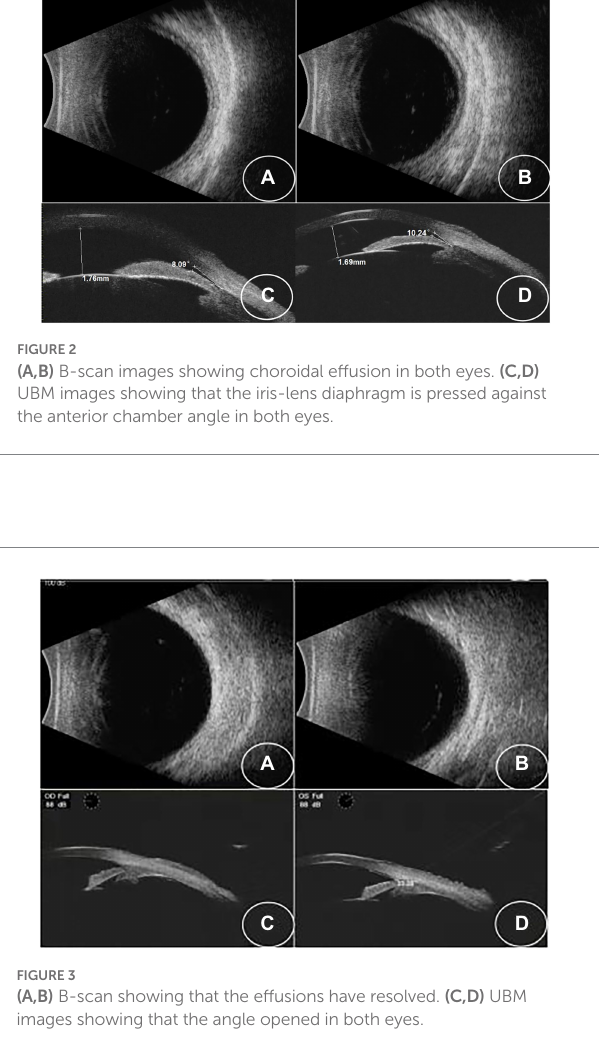
FIGURE 3 (A,B) B-scan showing that the effusions have resolved. (C,D) UBM images showing that the angle opened in both